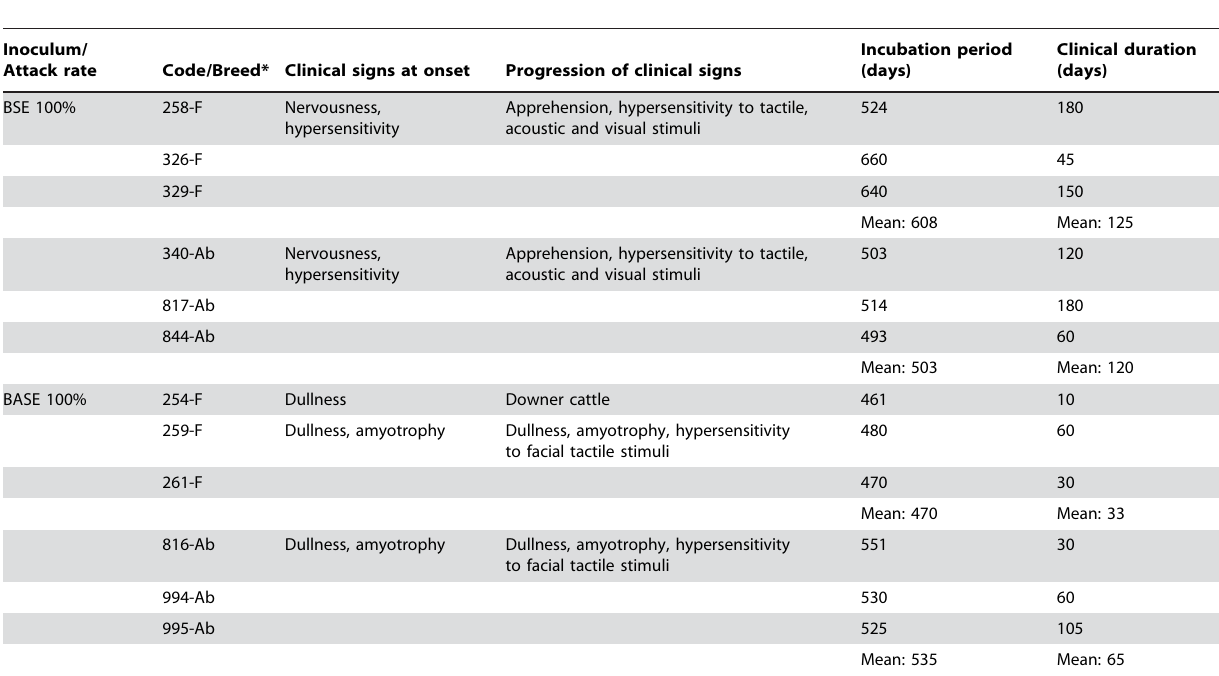
Table 2. Clinical phenotype, incubation period and clinical duration in BSE- and BASE-infected cattle.